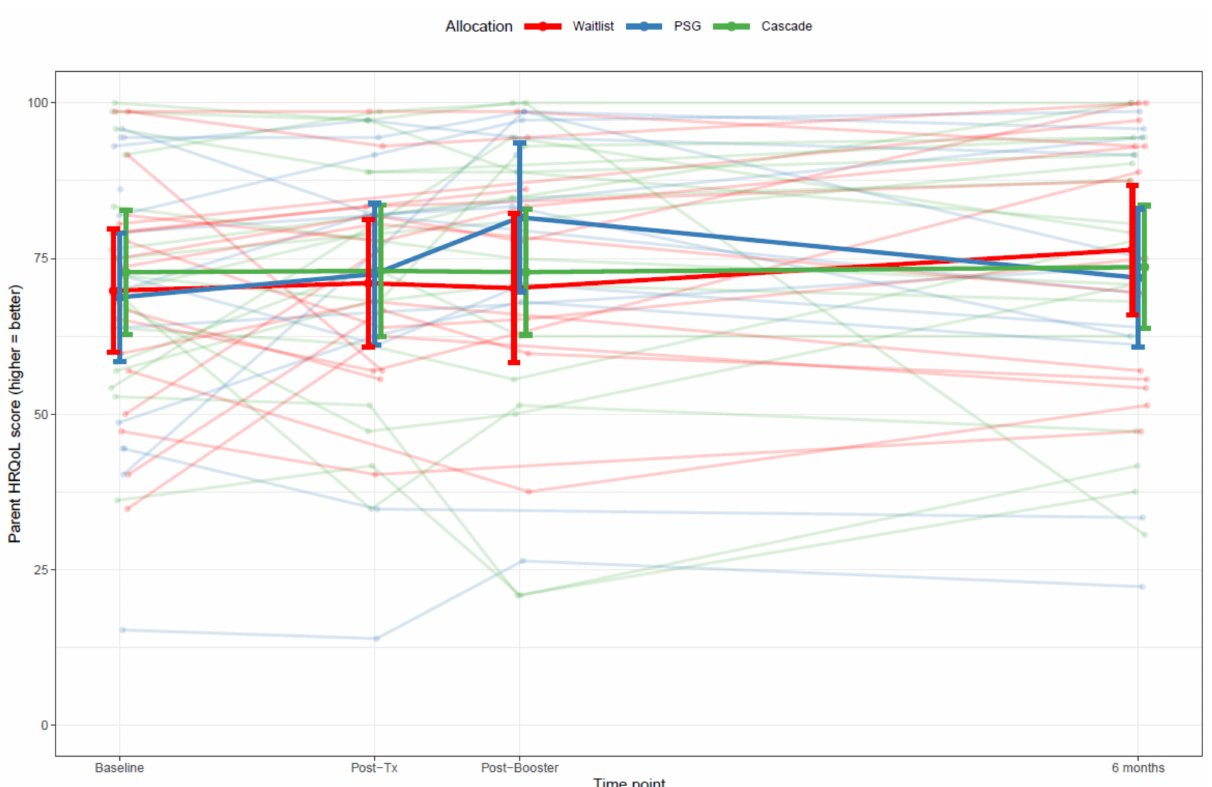
Figure 3. The PedsQL Family Impact Module health-related quality of life scores for parents in Cascade, peer-support and waitlisted groups across each time-point. Notes: The PedsQL HRQL Summary Score is computed as the sum of the items divided by the number of items answered in the physical, emotional, social and cognitive functioning subscales (for this study, only 18 of the 20 items were included two items from the physical scale (“I get headaches” and “I feel physically weak”) were not asked). If more than 50% of the items in the scale were missing, the summary score for that participant not computed at that time point. The above graph shows the individual scores over time, as well as the average scores (with 95% CI) in each study arm in bold . A 5-point response scale was utilized (0 = never a problem to 4 = always a problem), and items are reverse-scored and linearly transformed to a 0–100 scale, where higher scores indicate better functioning (i.e., less negative impact). Post-Tx: 2–4 weeks after intervention